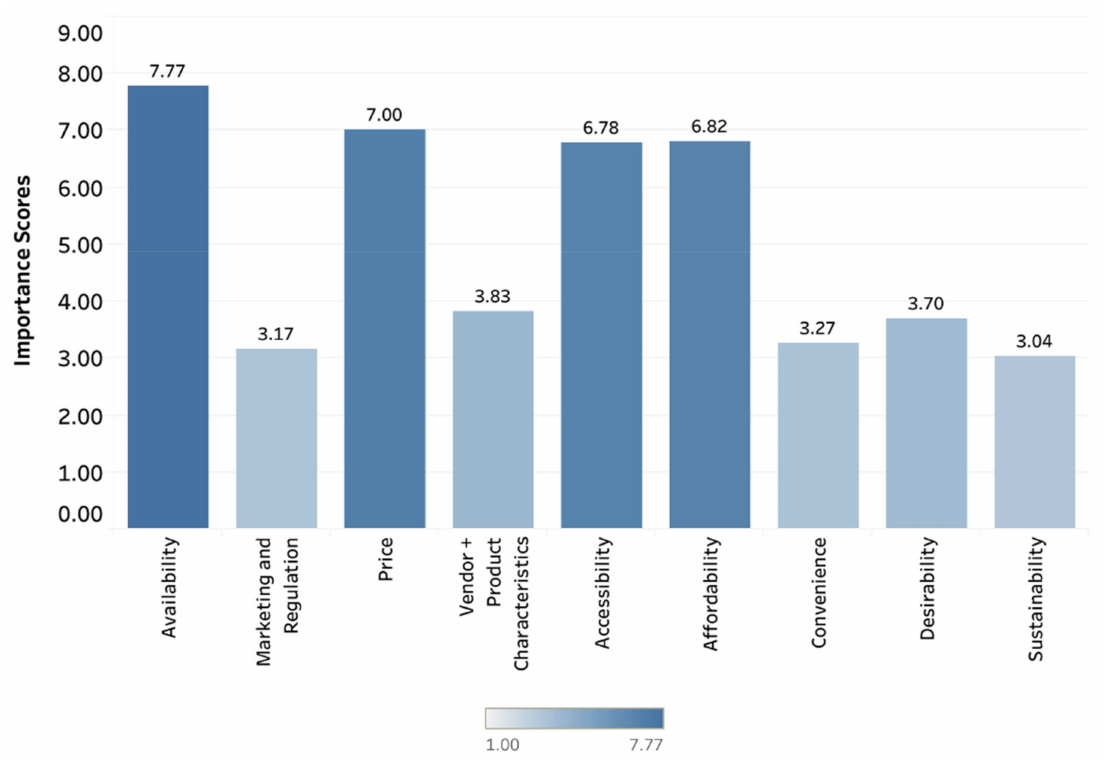
Figure 7. Importance Scores for Food-Environment Dimensions. Importance Scores based on the surveyed experts’ weighted rankings of the dimensions of the food-environment framework that they perceive as the most important to measure for understanding rural contexts in LMICs for influencing diets and nutrition from the perspective of